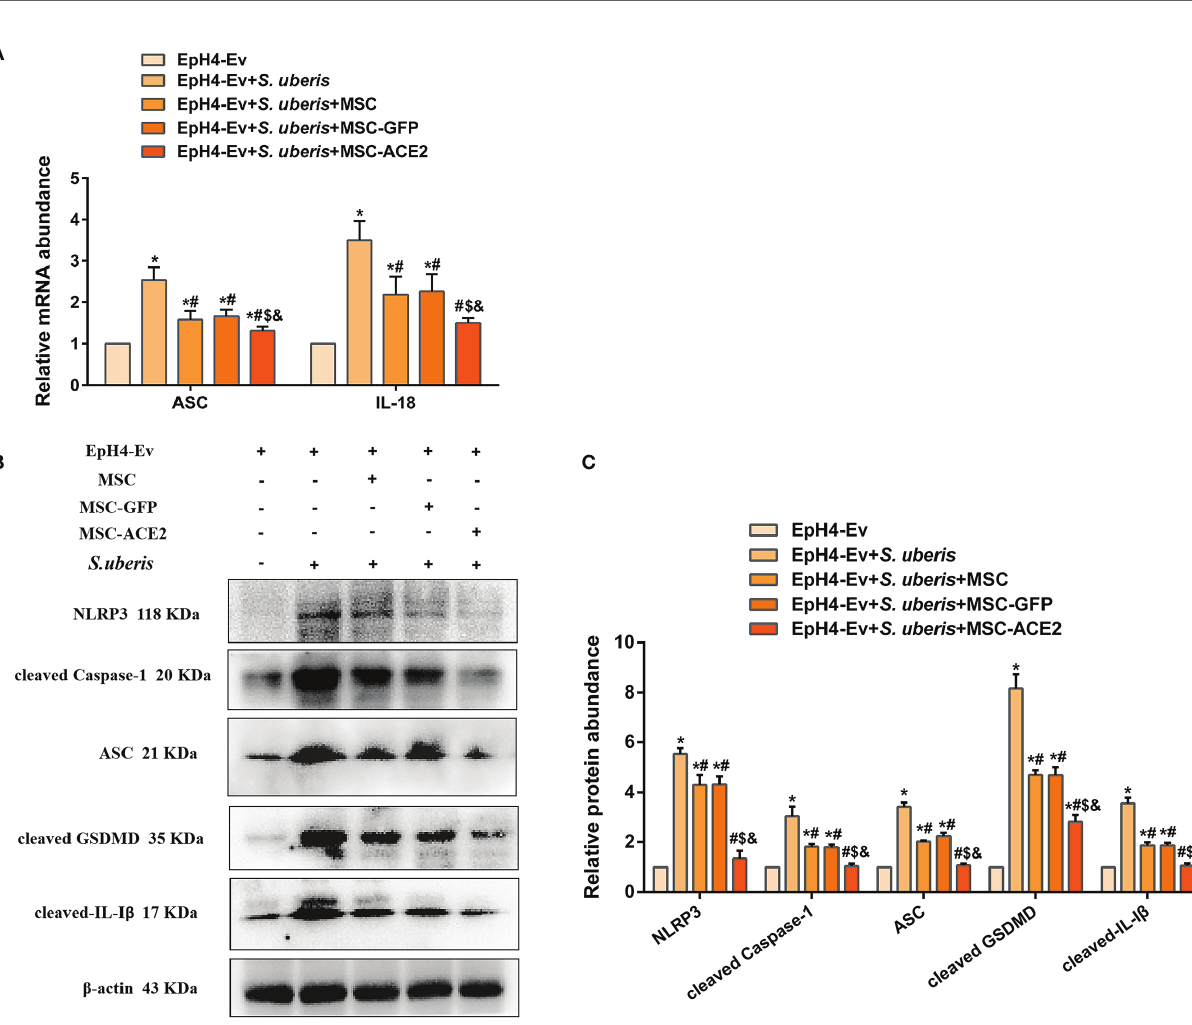
FIGURE 5 | MSC-ACE2 ameliorated S. uberis -induced Eph4-Ev cells pyroptosis. (A) Detection of relative transcript levels of ASC and IL-18 by qPCR (n = 4). (B) Detection of relative protein expression levels of NLRP3, cleaved-Caspase-1 (p20), ASC, cleaved GSDMD, and cleaved-IL-I b by Western blot. (C) Statistics of NLRP3, cleaved-Caspase-1 (p20), ASC, cleaved GSDMD, and cleaved-IL-I b Western blot results (n = 3). Experiments were repeated three times and data were presented as the mean ± SEM. * P < 0.05 vs. EpH4-Ev; # P < 0.05 vs. S. uberis ; $ P < 0.05 vs. MSC; & P < 0.05 vs.